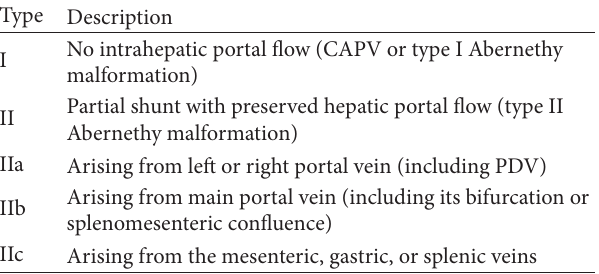
Table 2: Classification of congenital PSVS [17]. CAPV indicates congenital absence of the portal